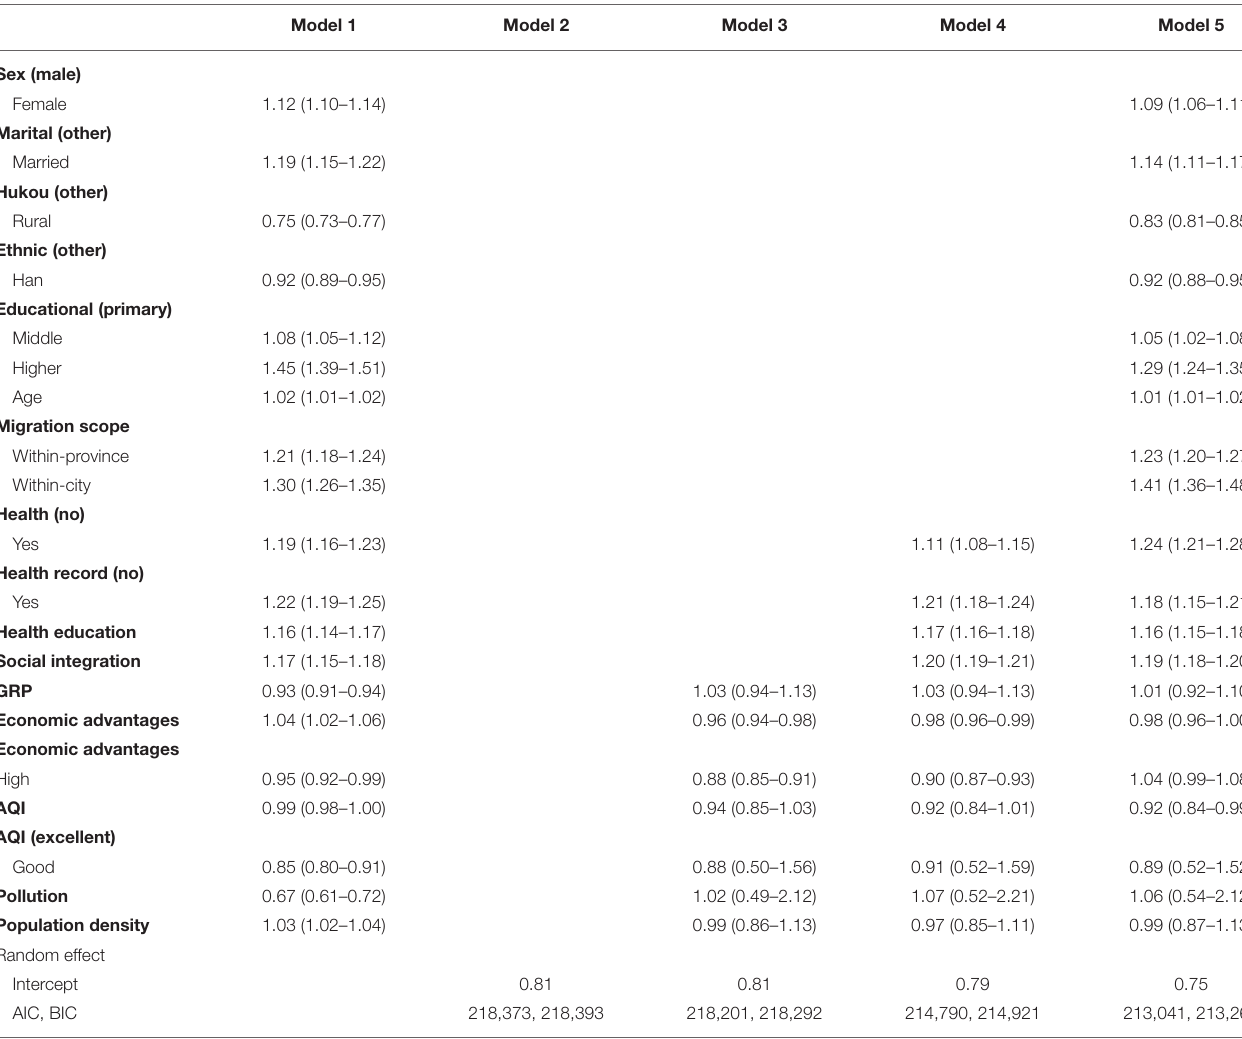
TABLE 4 | Multilevel mixed-effects logistic regression of settlement intention of